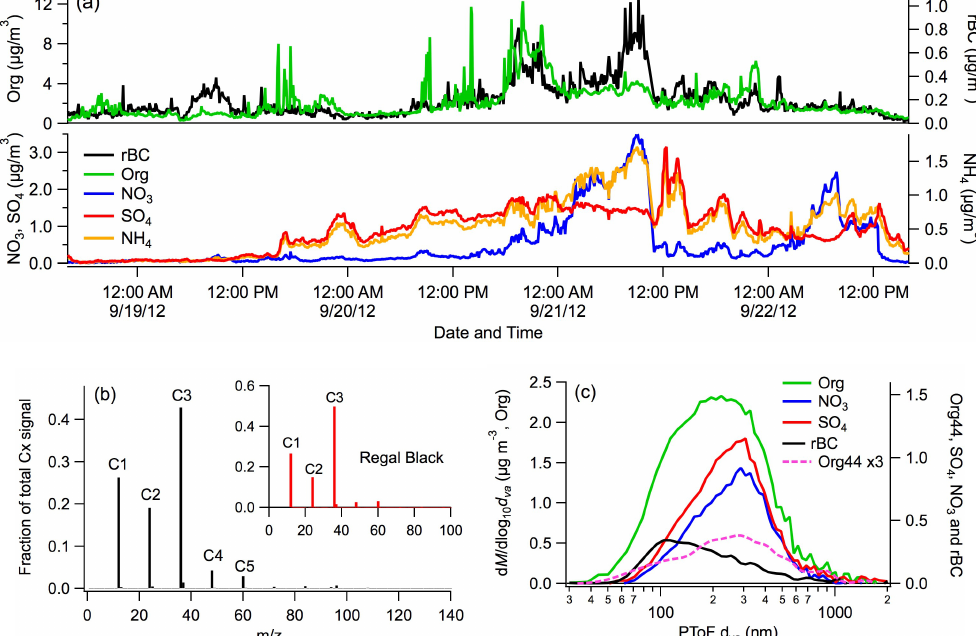
Figure 2. Summary of ensemble measurements. (a) Time series (local time) of laser-off (Org, NO 3 , SO 4 , NH 4 ) and laser-on (rBC) aerosol compositions. (b) The average mass spectrum of laser-on ambient rBC and Regal Black (insert). (c) Average size distributions of laser-off (Org, NO 3 , SO 4 , Org44) and laser-on (rBC) aerosol compositions. Org44 represents the organic signal at m/z 44 (e.g., CO +